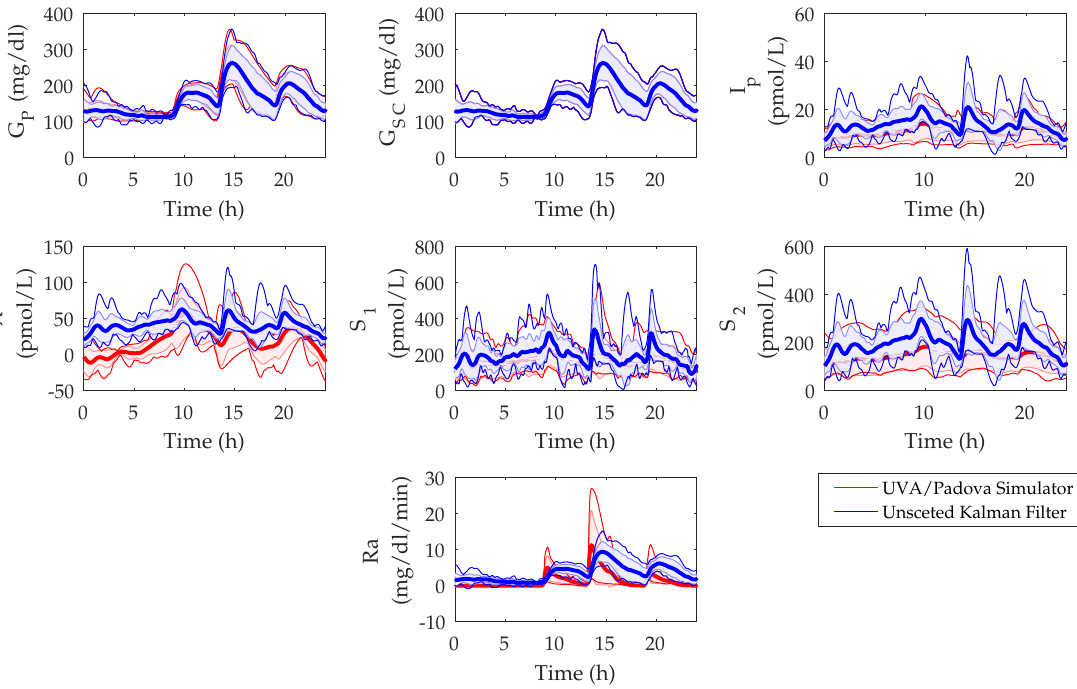
Figure 4. Population state estimations of the University of Virginia/Padova (UVA/Padova) Simulator versus the Unscented Kalman Filter over a 24 h period in silico. States shown are plasma glucose ( G P ), subcutaneous glucose ( G SC ), plasma insulin ( I p ), remote insulin ( X ), insulin in the first subcutaneous compartment ( S 1 ), insulin in the second subcutaneous compartment ( S 2 ), and rate of glucose appearance ( Ra ) equated to the disturbance parameter, D . Graph reported as mean (bold lines) ± standard deviation (lightly shaded area), minimum (thin lower line), and maximum values (thin upper